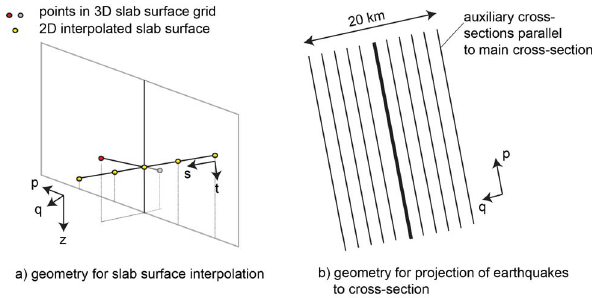
Figure A1 . a) Geometry used in interpolation of earthquake hypocenters in 3D onto a 2D cross-section. We find nearest neighbors on either side of the cross-section (red and grey circles) within approximately 1 km distance (in q). Linear interpolation yields the 2D slab surface (yellow circles). We use a local slab coordinate system with s parallel to the top of the slab and t perpendicular to the slab surface. b) We project earthquakes from within a 22 km swath around the main cross-section. To make the projection more accurate we set up auxiliary cross-sections at distances of 2, 4, 6, 8 and 10 km parallel to the main cross-section (shown in bold). We define the slab surface in each auxiliary cross-section as in a) and project the earthquake coordinates to local (s,t) coordinates, which are then accumulated to represent the earthquake locations in the main cross-section.